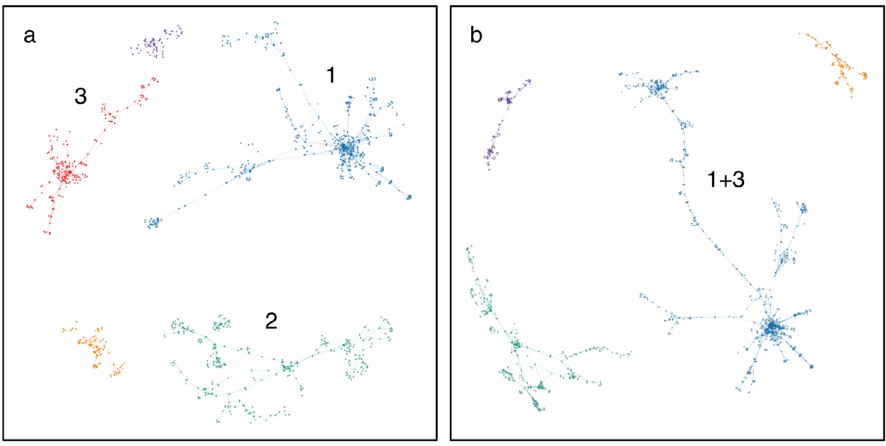
Fig 6. Visualization of the top components in the ALD collaboration network by number of nodes (authors) in 2000 (a) and 2001 (b). Components1 and 3 in merge, resulting in the increase in the average path lengthin 2001 observedin Fig